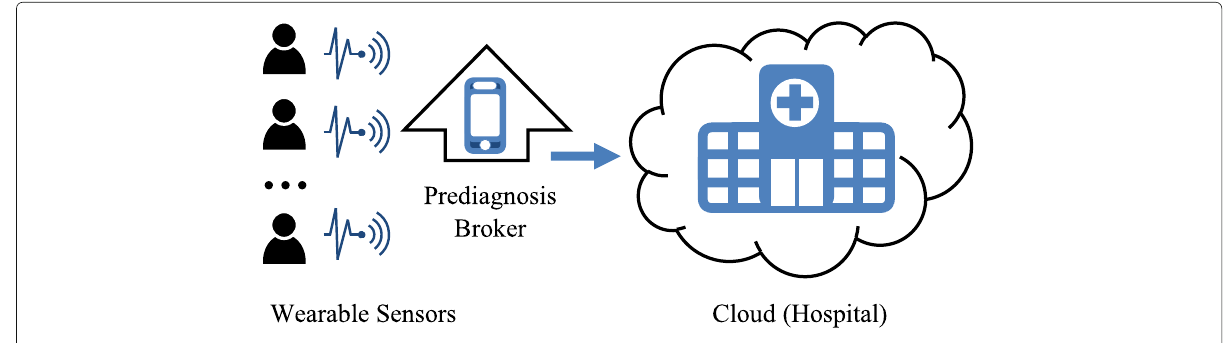
Fig. 4 The scenario of cooperative remote health monitoring